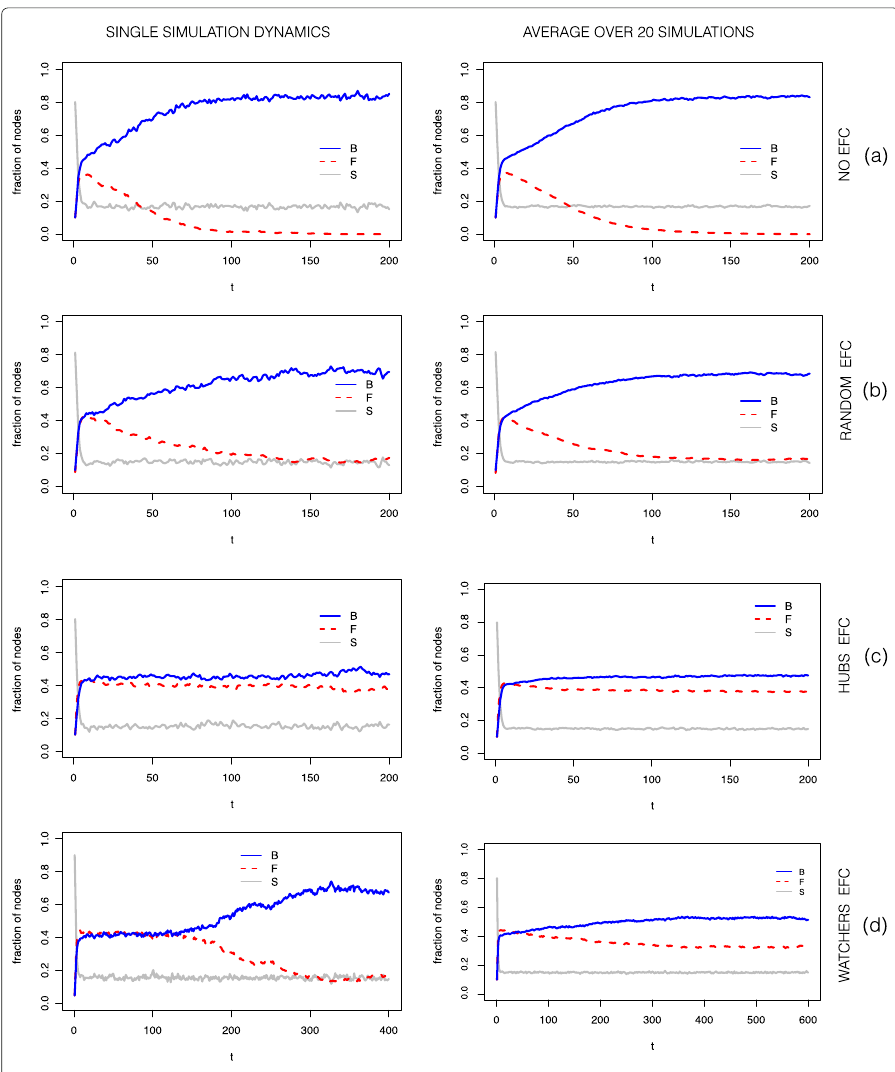
Fig. 5 Synthetic Segregated Networks. Different strategies of choosing some nodes as eternal Fact Checkers (eFC) in a segregated network with skeptic and gullible communities: a no eFC, b eFC at random in the skeptic community, c eFC in the highest degree nodes of the skeptic community, d eFC on the frontier among the two communities (nodes in the skeptic group that are connected with nodes in the gullible one). The plots on the left column represent the dynamics of just one simulation of the model to emphasize the moment in which the Believer invade the skeptic community in case ( d ). The plots on the right column show the average dynamics over 20 simulations. Moreover, for cases ( a ), ( b ) and ( c ) the equilibrium is reached at t < 200, while in ( d ) we needed t ≈ 400 time